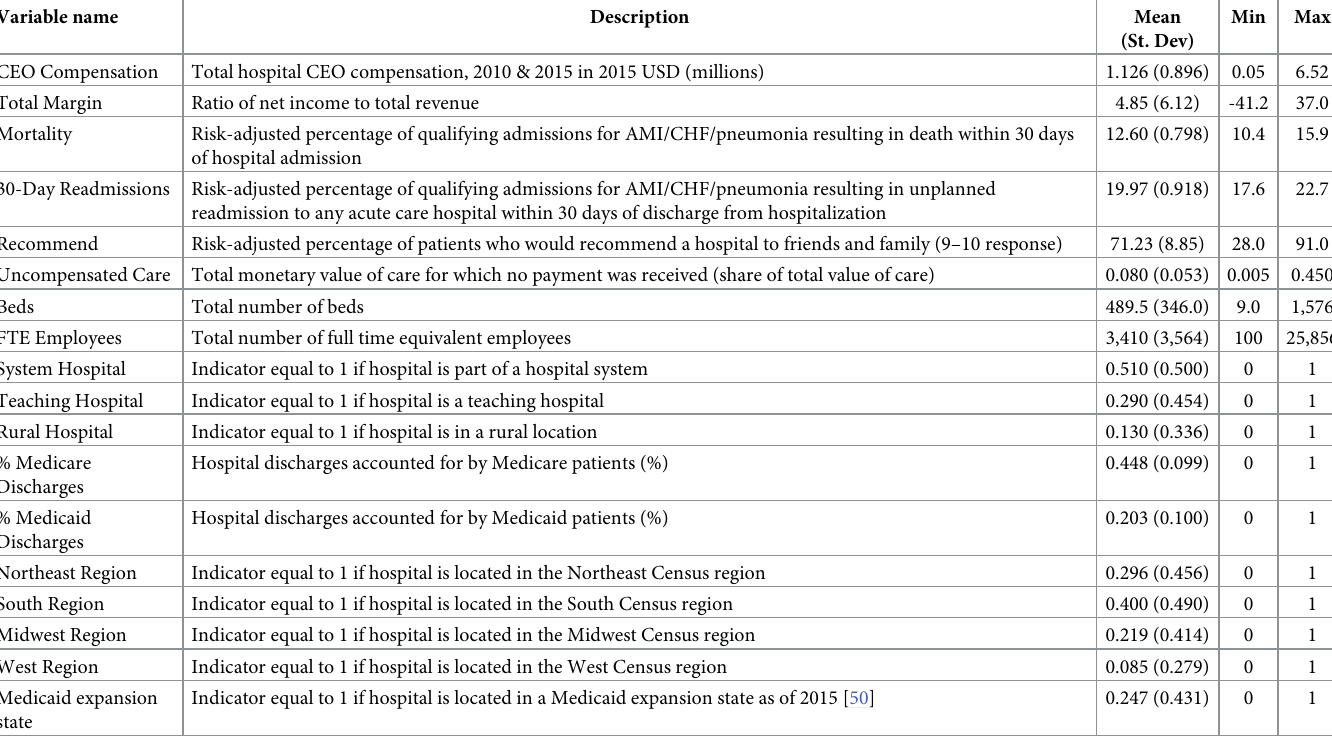
Table 1. Summary